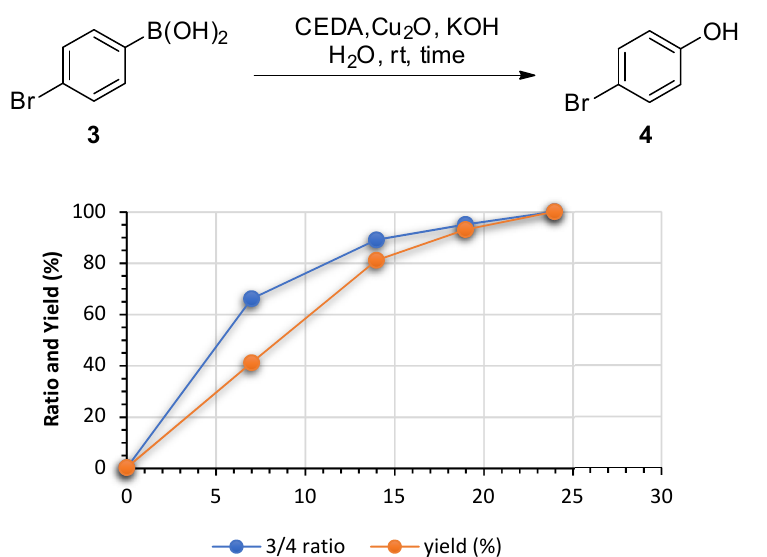
Figure 5. Optimization of reaction time using CEDA-[Cu]. In blue dots/line, the ratio determined by 1 H-NMR. In orange dots/line isolated yields.